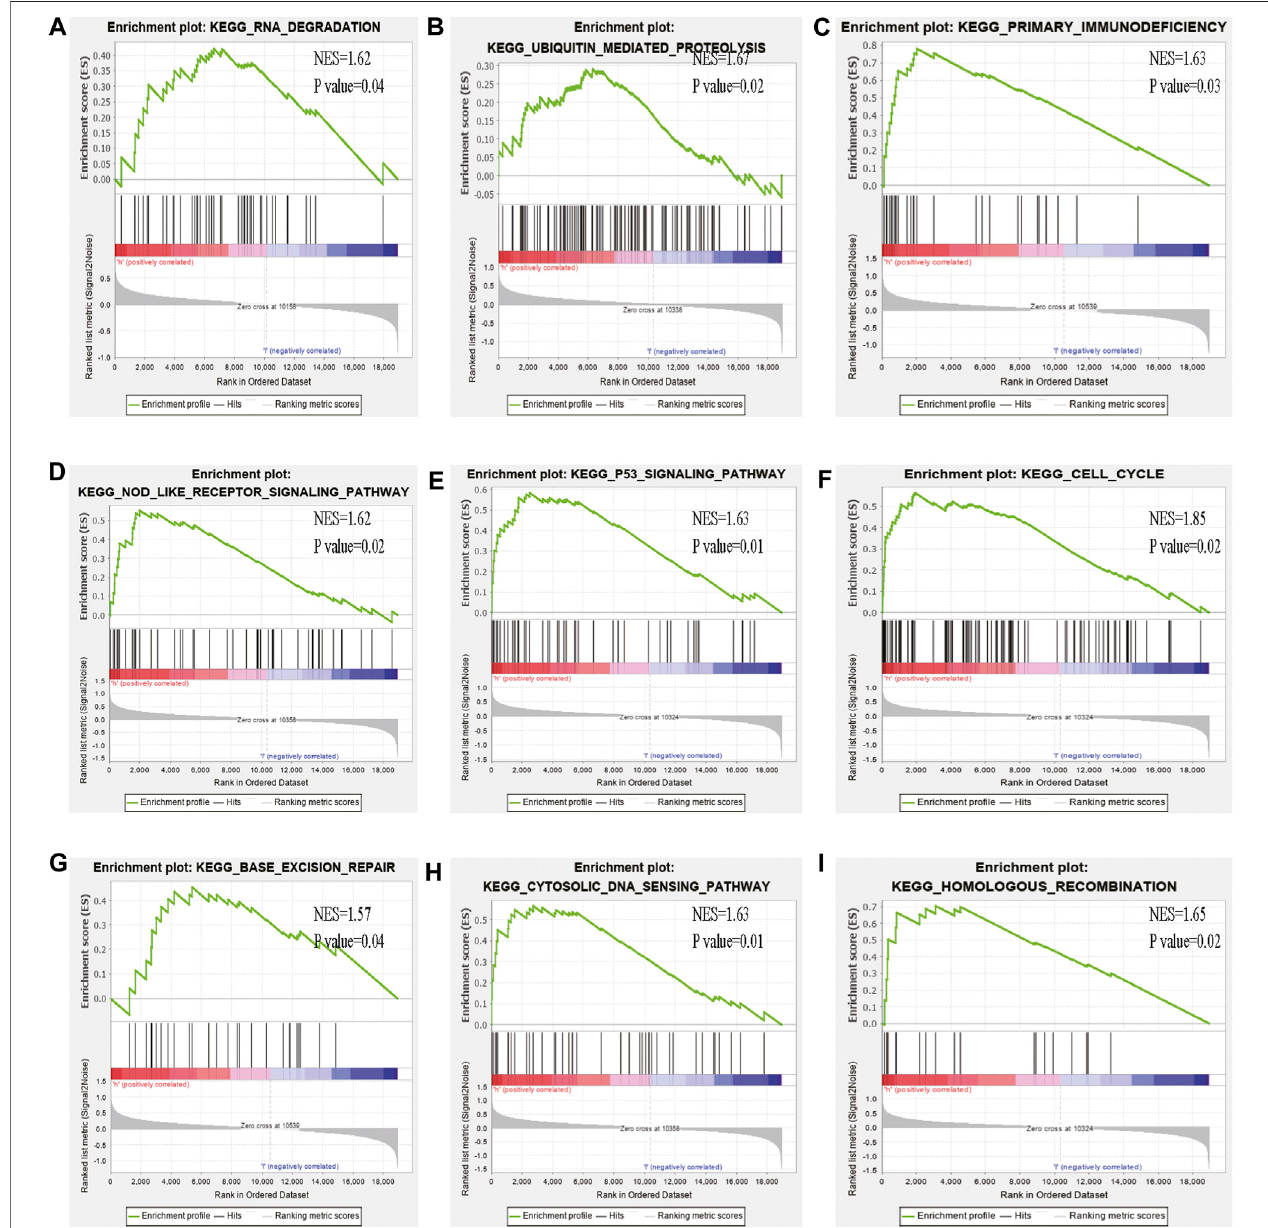
FIGURE 10 | GSEA analysis of the high- and low-risk groups (A – I) Some cancer-related pathways were prevalent in the high-risk group: “ Nod like receptor signaling pathway, ” “ P53 signaling pathway, ” “ cell cycle, ” “ homologous recombination, ” “ base excision repair, ” “ cytosolic dna sensing pathway, ” “ ubiquitin mediated proteolysis, ” “ primary immunode fi ciency, ” “ DNA dergradation, ” NES, Normalized enrichment score.